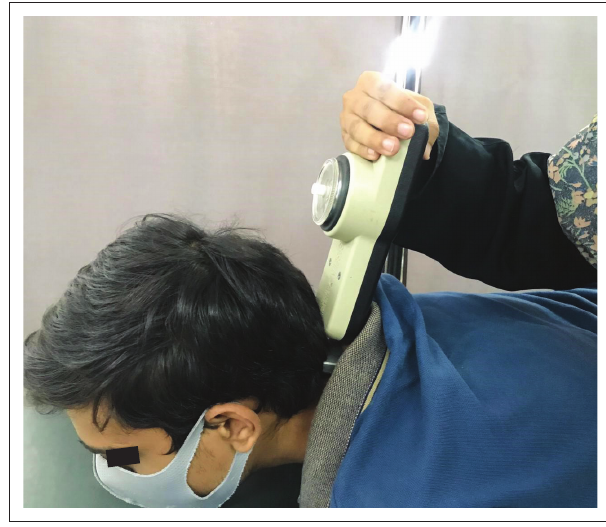
FIGURE 3: Measurement of the neck flexor strength with the handheld dynamometer.